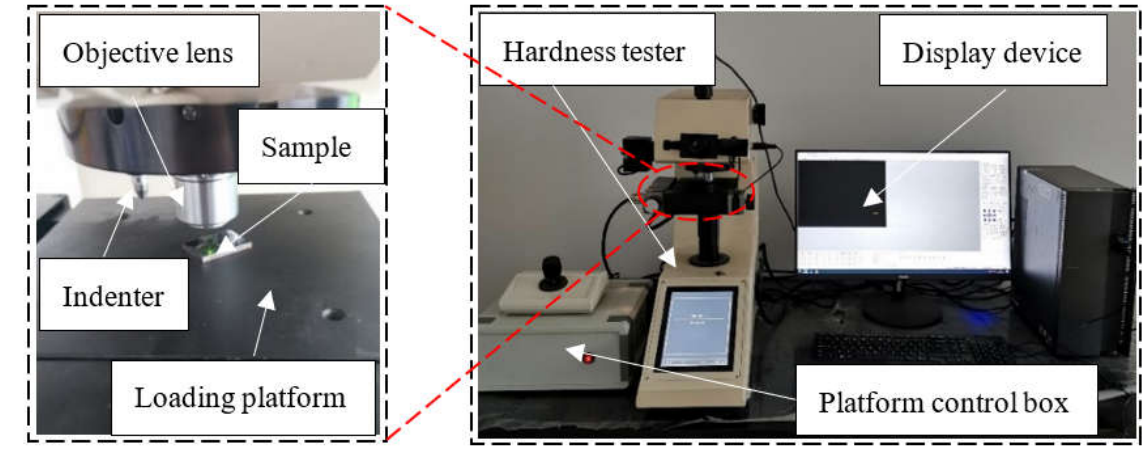
Figure 11. Automatic micro-Vickers hardness measuring system.